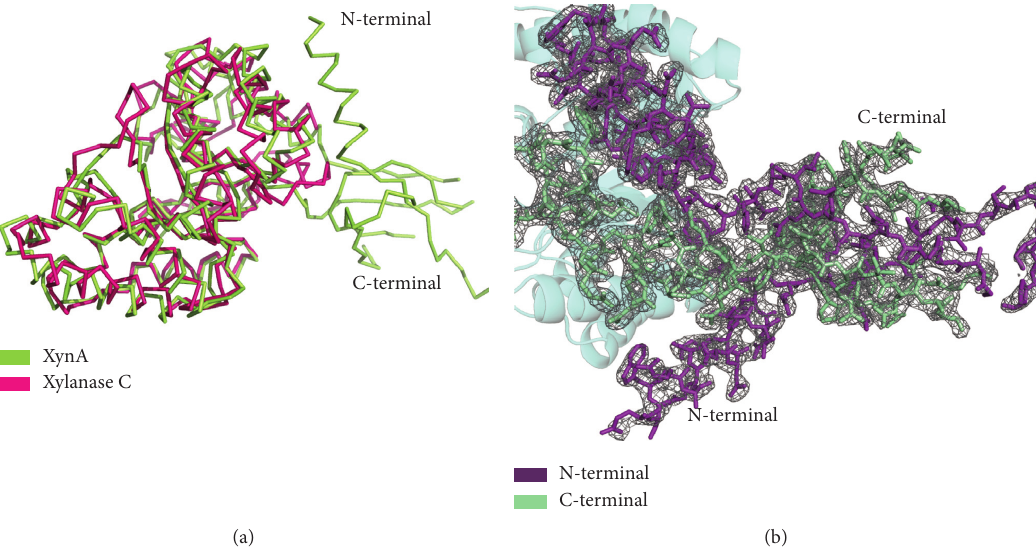
Figure 2: Structure comparison. (a) Protein structure comparison of XynA and xylanase C. Xylanase C (PDB ID 4XUY) is an endo- β -1,4- xylanase from Aspergillus niger . XynA and xylanase C are coloured lemon yellow and magenta, respectively. (b) Electron density map of the XynA N-terminal and C-terminal domains. The simulated annealing omit of the 2Fo-Fc map is contoured at 1 σ , and the N-terminal domain and C-terminal domain are labelled in purple and pale